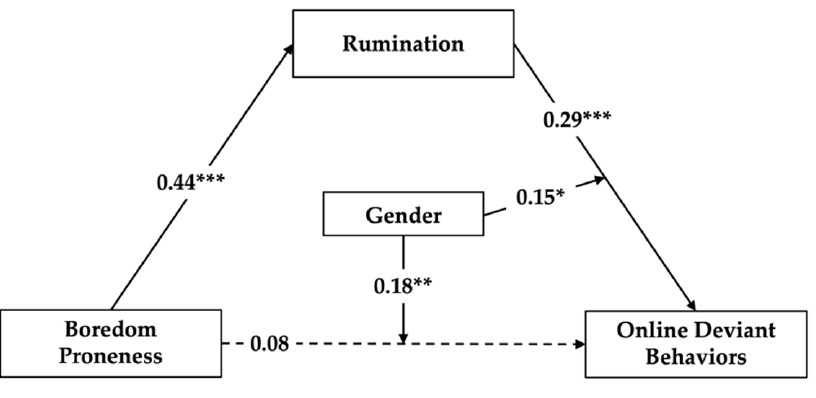
Figure 1. The moderated mediation model. Table 3. The conditional direct and indirect effect